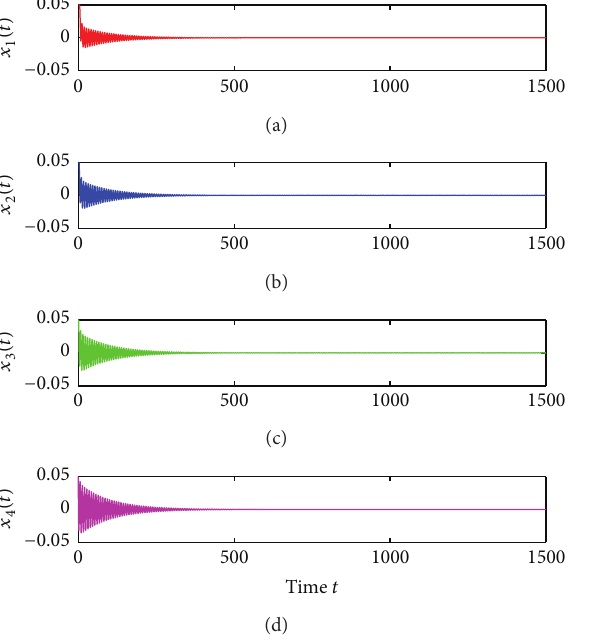
Figure 3: The trajectory of 𝑥 1 , 𝑥 2 , 𝑥 3 , and 𝑥 4 when 𝜏 1 = 1.5 > 1.4022 = 𝜏 10 .